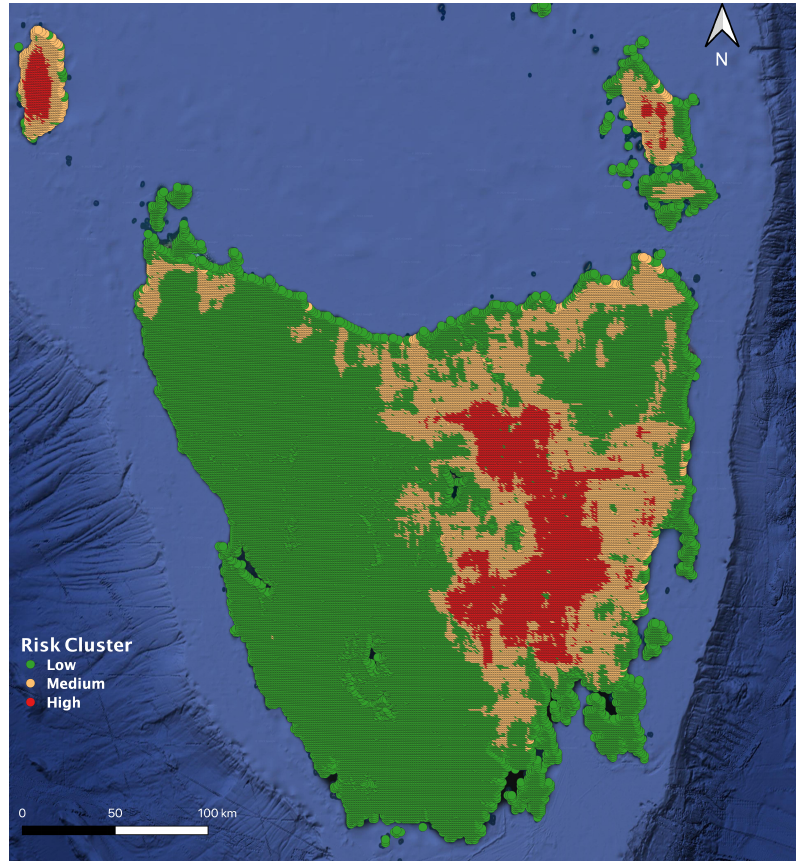
Figure 4. Risk zone characterization of all possible fire start locations in Tasmania.